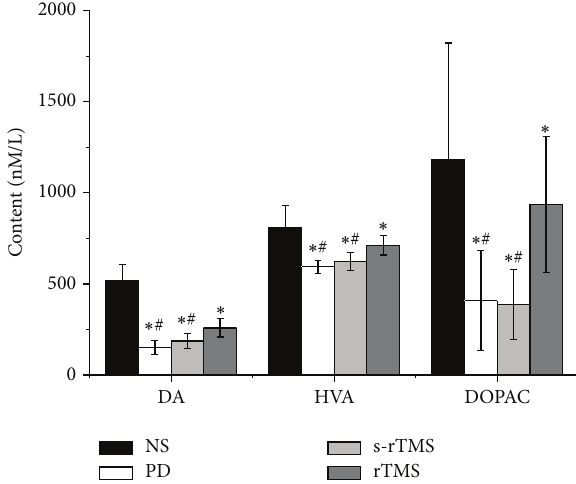
Figure 2: The comparison of the locomotor activity in different groups at different time points.